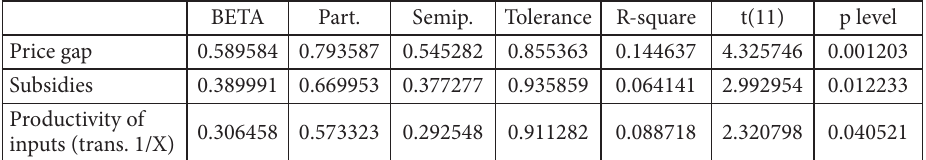
Table 6. Partial and semi-partial correlations for variables from Eq. (3) BETA Part.